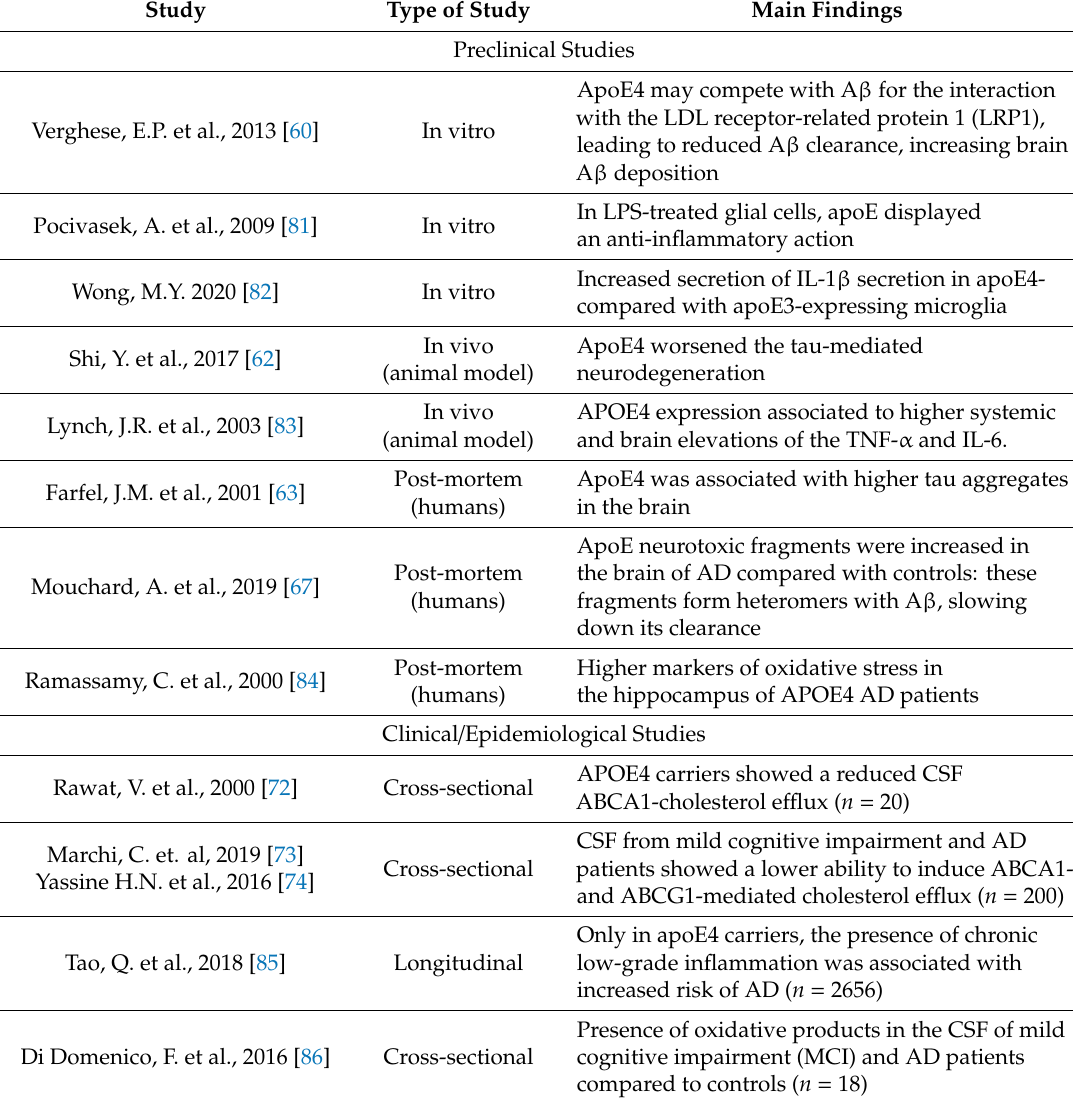
Table 2. Selection of preclinical and clinical evidence supporting the role of apolipoprotein E (apoE) in protecting from Alzheimer’s disease